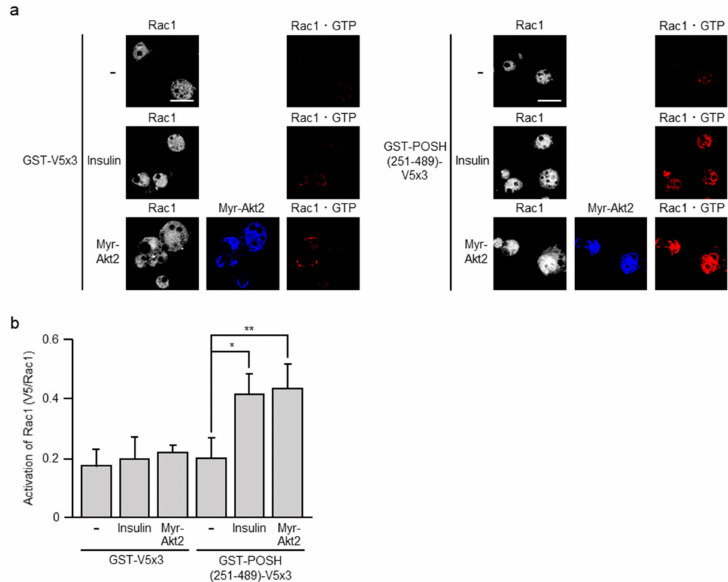
Figure 5. The formation of GTP-bound active Rac1 (Rac1 · GTP) by ectopic expression of constitutively activated Akt2. ( a ) 3T3-L1 adipocytes were infected with the control (-) or Myr-Akt2-expressing virus. Endogenous Rac1 was visualized by immunofluorescent microscopy using an anti-Rac1 antibody. Myr-Akt2 was visualized by immunofluorescent microscopy using an anti-HA antibody. Rac1 · GTP was visualized by immunofluorescent microscopy using an anti-V5 antibody after treatment with glutathione S -transferase (GST)-POSH(251–489)-V5 × 3, but not GST-V5 × 3. Scale bar, 50 µ m. ( b ) The formation of Rac1 · GTP shown in (a) was quantified. Data are shown as means ± S.E. ( n = 10). * p < 0.05; ** p <